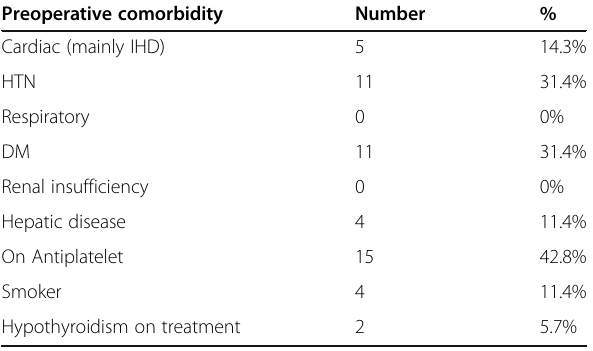
Table 3 Preoperative comorbidity Preoperative comorbidity